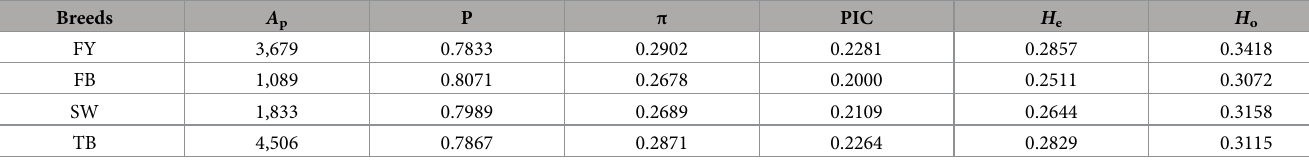
Table 1. Values of genetic diversity in four rabbit breeds using SNP data.